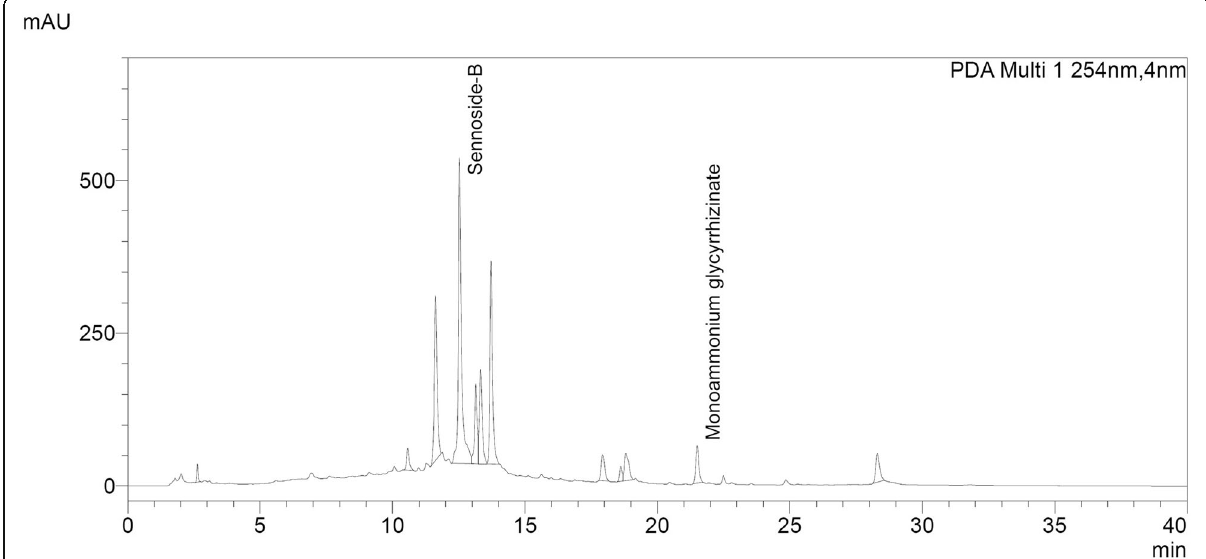
Fig. 2 HPLC chromatogram of polyherbal laxative formulation — Vasulax